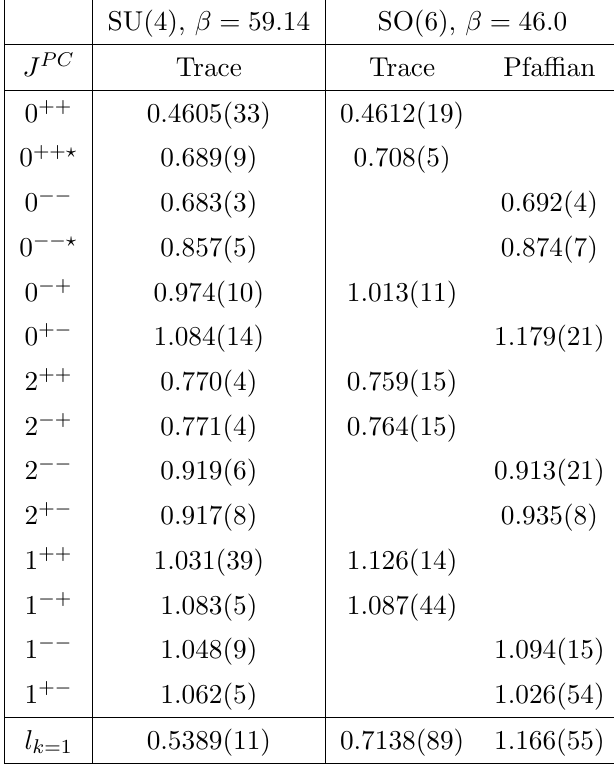
Table 4 . Lightest glueball masses in SU(4) and SO(6) on a 46 2 48 lattice at the couplings shown for various spins J and parity P . For SU(4) labelled by charge conjugation C , and for SO(6) in the two sectors indicated, as explained in text. Also shown is the energy of the lightest k -string, l k , winding around a periodic spatial